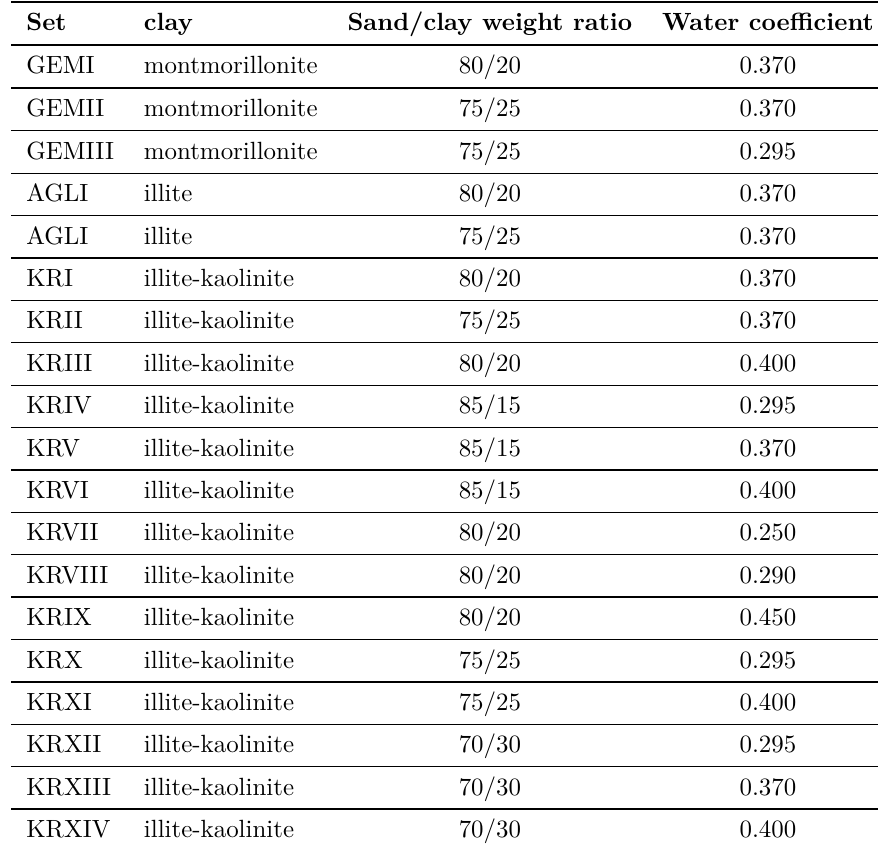
Table 2. Summary of the earth mixtures.